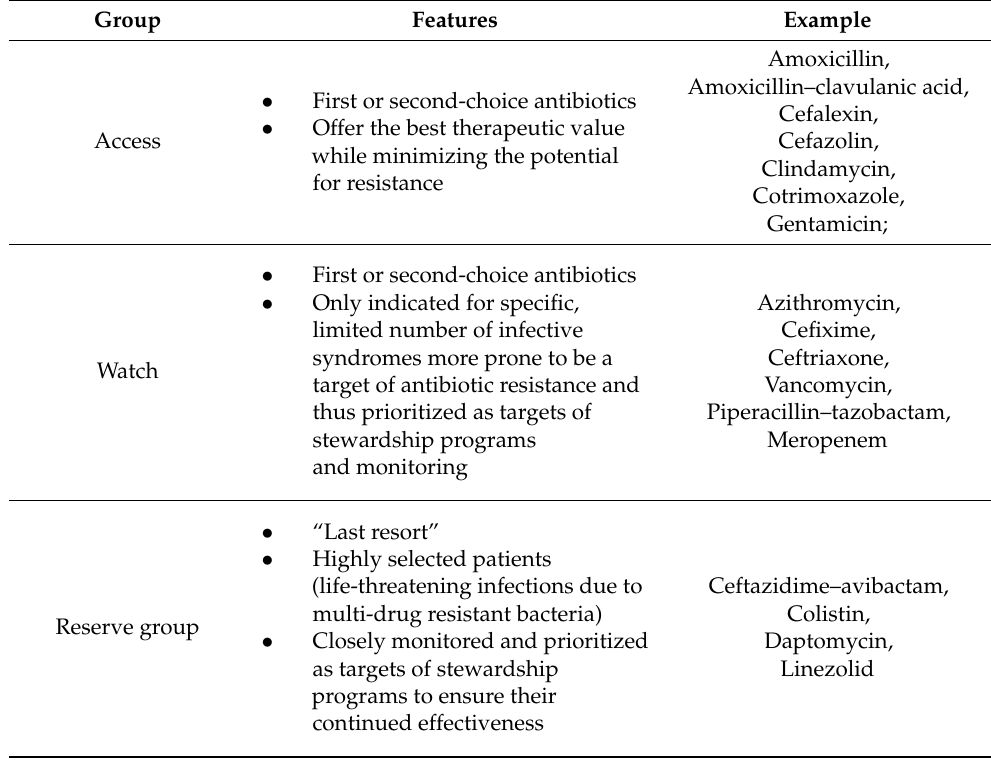
Table 1. AWaRe classification (modified by